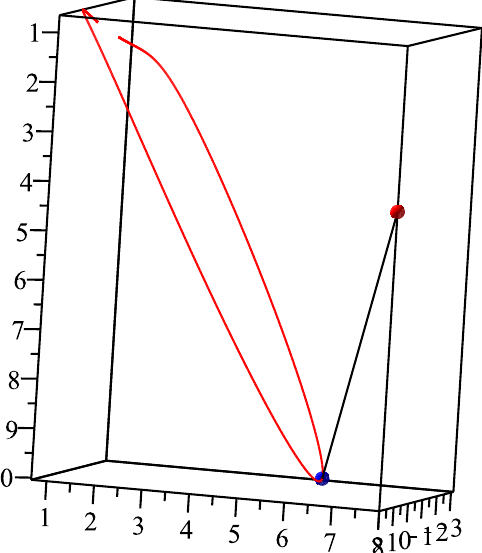
Figure 9. Geometric illustration for the second case of Example